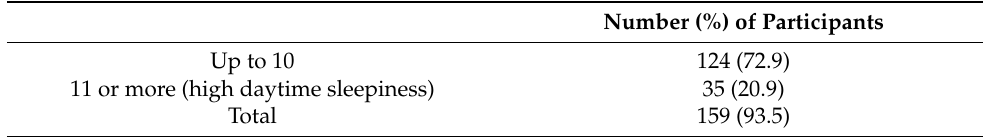
Table 5. Distribution of participants according to daytime sleepiness.